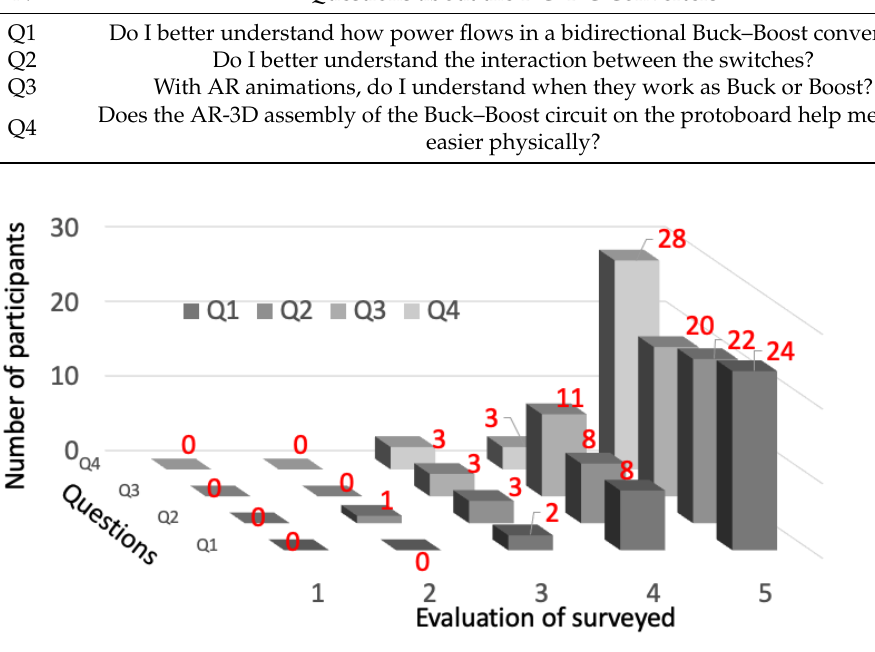
Figure 13. AR-DC–DC survey.